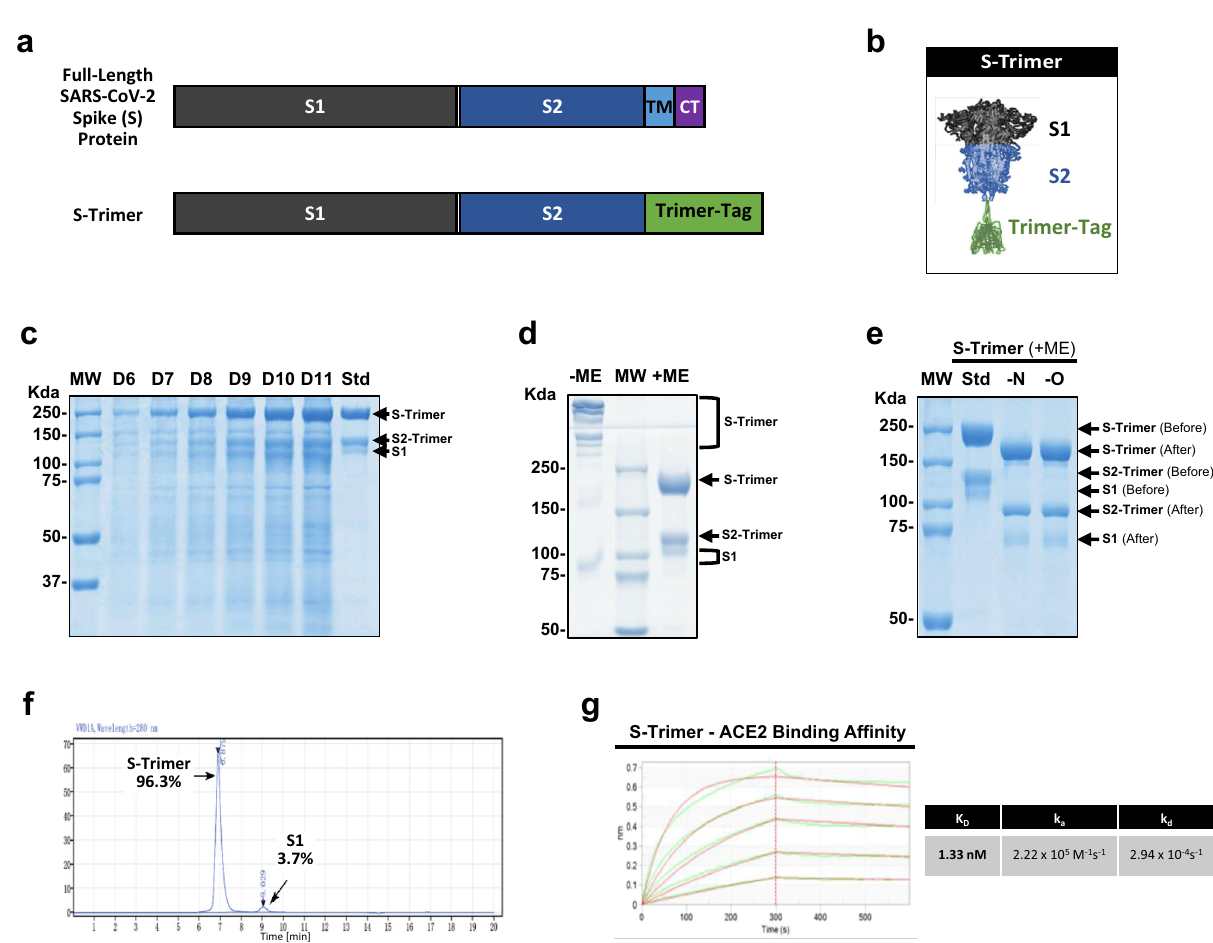
Fig. 1 High-level expression and characterization of S-Trimer. a Schematic representations of full-length SARS-CoV-2 Spike (S) protein and the ectodomain of wild-type SARS-CoV-2 S protein-Trimer-Tag fusion protein (S-Trimer). b Schematic 2-D illustration of S-Trimer with homotrimeric Spike protein in the prefusion conformation. c Reducing SDS-PAGE analysis with Coomassie Blue staining of high-level expression of S-Trimer as a secreted protein from CHO cells in a 15L bioreactor Fed-batch serum-free culture over 11 days (10 µ L of cleared media were loaded for each sample) along with a puri fi ed standard (Std). d S-Trimer is a disul fi de bond-linked homotrimer as analyzed by SDS-PAGE with Coomassie Blue staining under